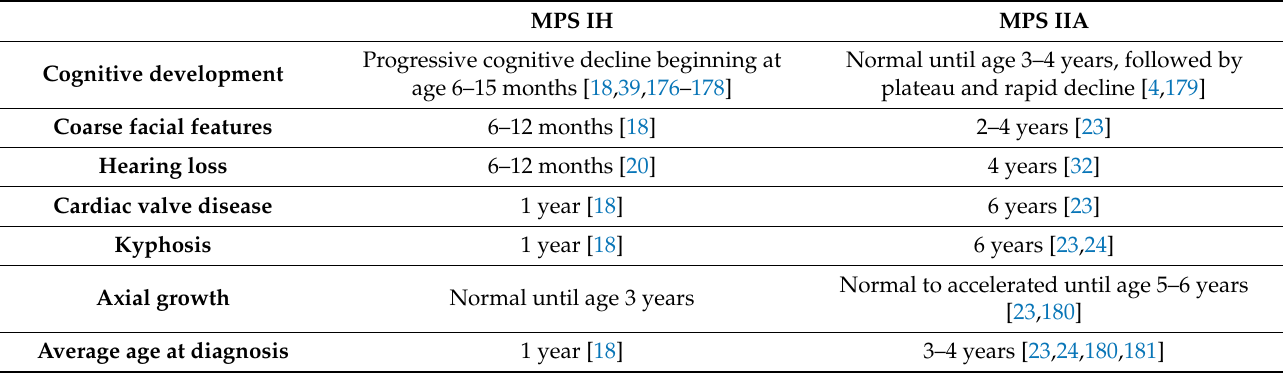
Table 2. Earliest time for manifestations in patients with MPS IH and MPS IIA.